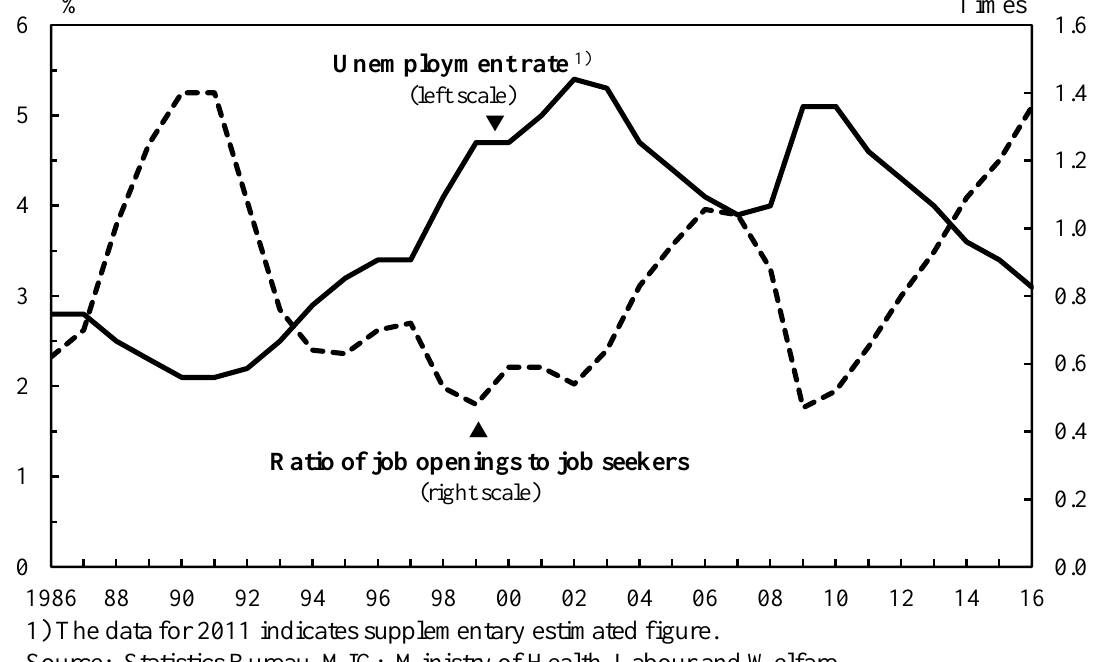
Unemployment Rate and Ratio of Job Openings to Job Seekers